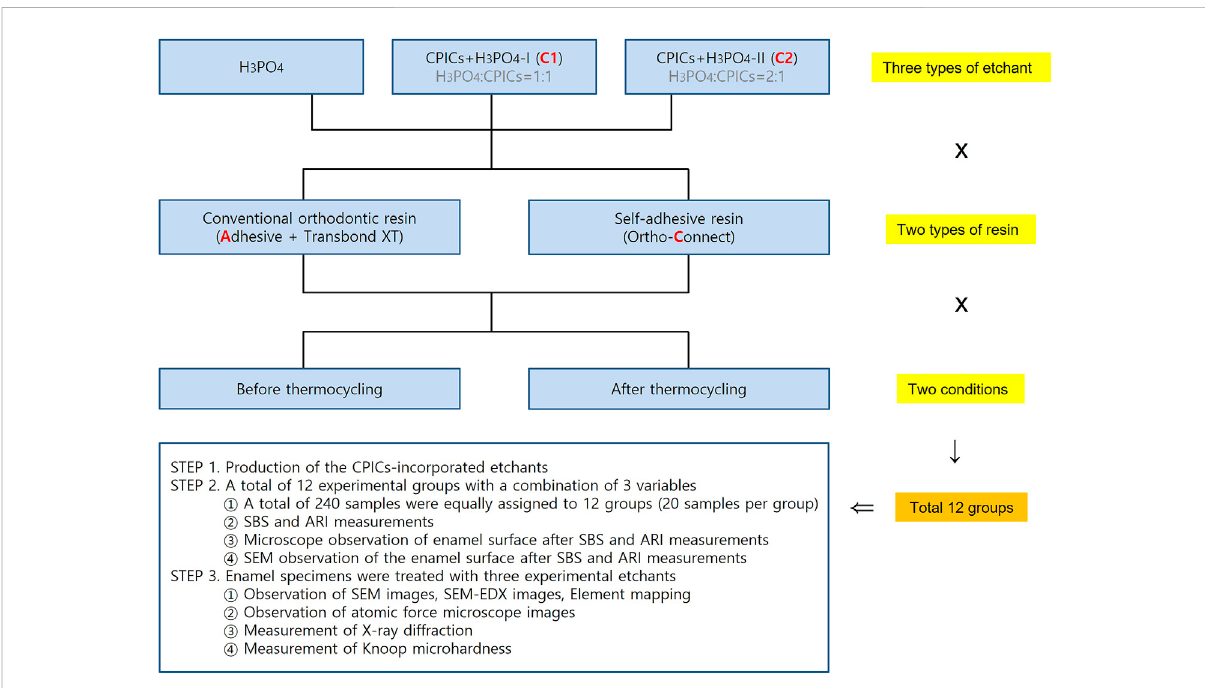
FIGURE 1 Experimental group design. Groups A and C were control groups that used pure 35% H 3 PO 4 without CPICs. Group A used adhesive and TransbondXTresin,whereasGroupCusedOrthoConnectself-adhesiveresin.C1andC2wereexperimentalgroupsthatusedCPIC-incorporatedin H 3 PO 4 at a 1:1 (CPICs + H 3 PO 4 -I) and 1:2 (CPICs + H 3 PO 4 -II) volume ratios, respectively. Thus, the CPIC content of C2 was lower than that of C1. Three types of etchants (according to the inclusion and proportion of CPICs), two types of resins, and two conditions for thermocycling were used; thus, the experiment included 12 groups in total (H 3 PO 4 , phosphoric acid; CPICs, calcium phosphate ion